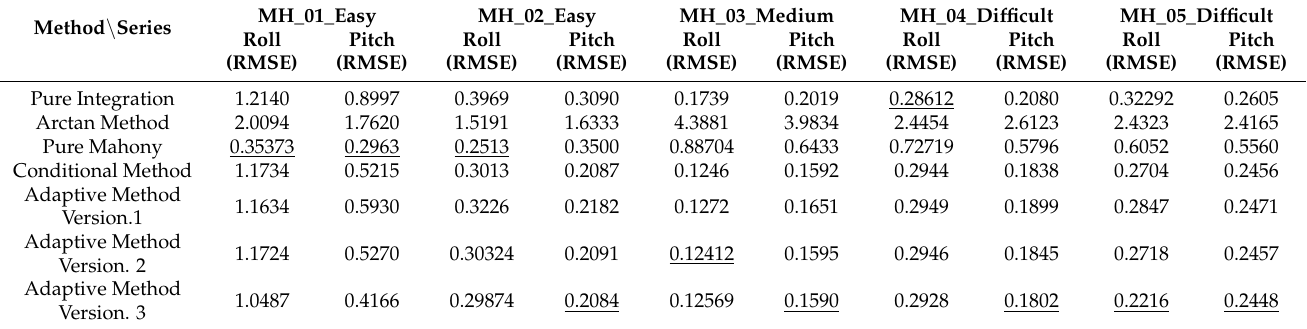
Figure 13. Roll and pitch angles were obtained from different adjustment strategies for the MH_04_difficult series. Table 4. Results of online adaptive K p tuning algorithm for EuRoC dataset. (Unit: deg).